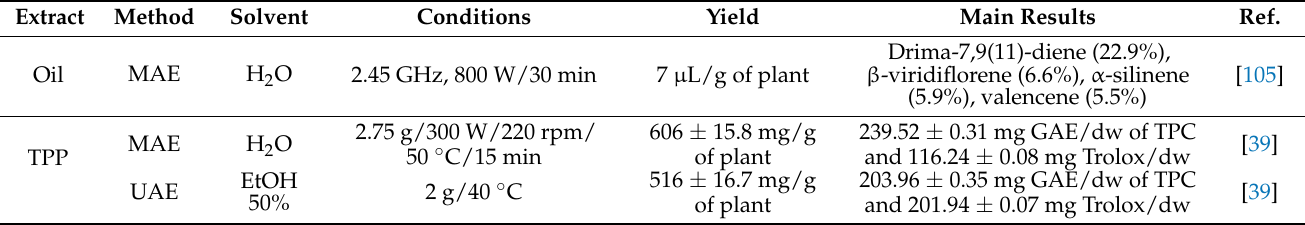
Table 2. Polyphenols and essential oils from damiana ( Turnera diffusa ) extracted by ecofriendly methods. Extract Method Yield Main Results